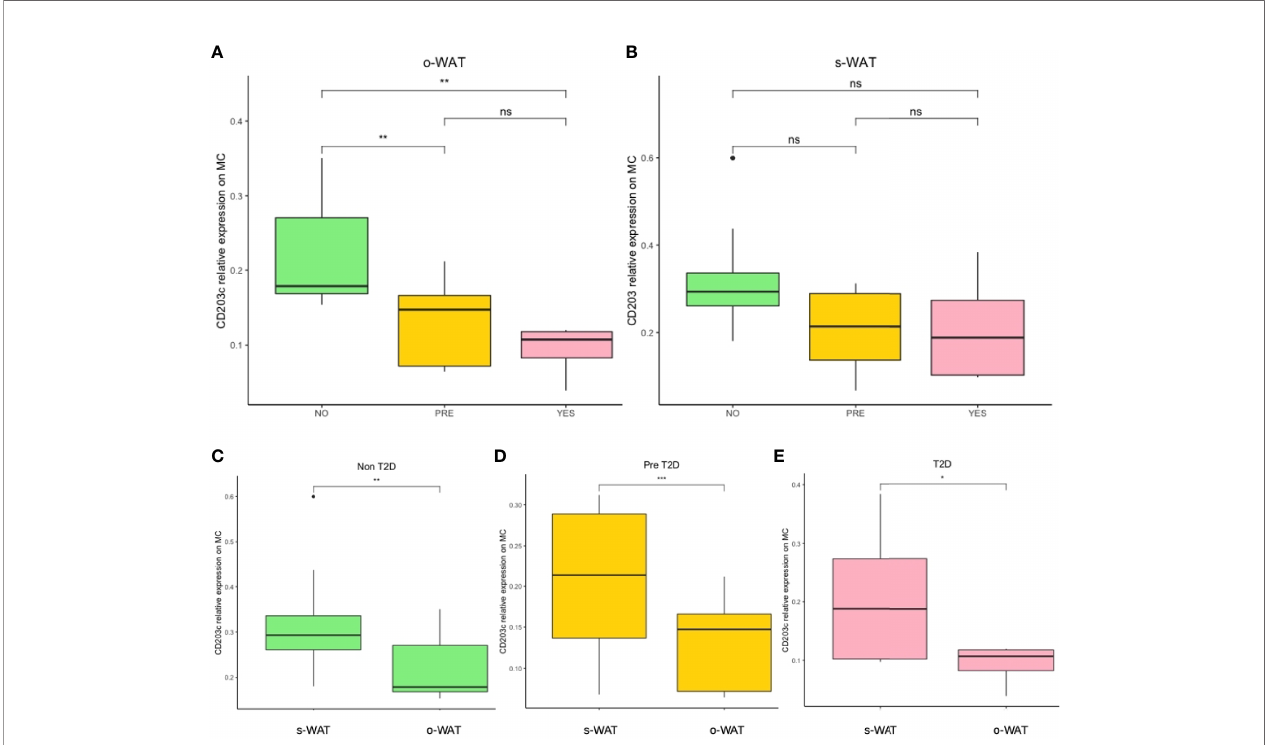
FIGURE 5 | Relative surface expression of CD203c on mast cells. (A) Comparison in o-WAT between the three groups. (B) Comparison in s-WAT between the three groups. (C) Comparison between o-WAT and s-WAT in the non-T2D group. (D) Comparison between o-WAT and s-WAT in the pre-T2D group. (E) Comparison between o-WAT and s-WAT in the T2D group. MC (mast cells), s-WAT (subcutaneous white adipose tissue), o-WAT (omental white adipose tissue), NO (non-type 2 diabetes group), PRE (pre type 2 diabetes group), YES (type 2 diabetes group), T2D (type 2 diabetes), n=27. “ ns ” means not signi fi cant, * (0.05 > p value > 0.01), ** (0.01 > p value > 0.001), *** (0.001 > p value >